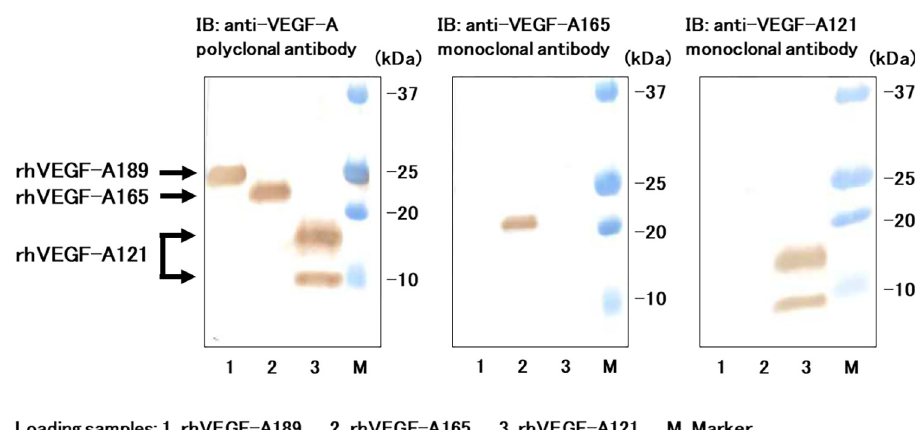
Fig 1. Immunoreactivity of the anti-VEGF-A121 and anti-VEGF-A165 monoclonal antibodies. Mixture of rhVEGF-A121, rhVEGF-A165 and rhVEGF-A189 (50 μ g each) were subjected to 15% SDS Polyacrylamide Gel Electrophoresis (SDS-PAGE). The transferred membrane was detected with anti-VEGF-A polyclonal antibody (left panel), anti-VEGF-A165 monoclonal antibody (middle panel), and anti-VEGF-A121 monoclonal antibody (right panel). The upper band of VEGF-A121 bands in SDS-PAGE (Lane 3) is due to glycosylation according to manufacturer’s instruction provided from Cell Signaling Technologies.